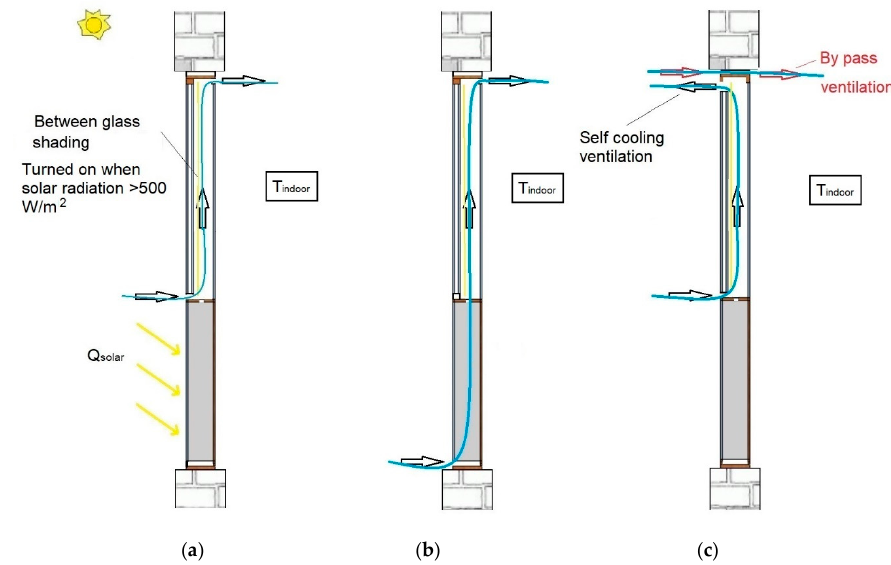
Figure 5. The working principle of the PCMVW during winter [14]. ( a ) Heat storage mode, when I > 200 W/m 2 ). ( b ) Heat release mode, when T indoor < 24 °C . ( c ) Overheating preventing mode, when T indoor >= > 200 W / m 2 ). ( b ) Heat release mode, when T < 24 ◦ C. ( c ) Overheating preventing mode, when indoor 24 °C . T indoor >= 24 ◦ C.